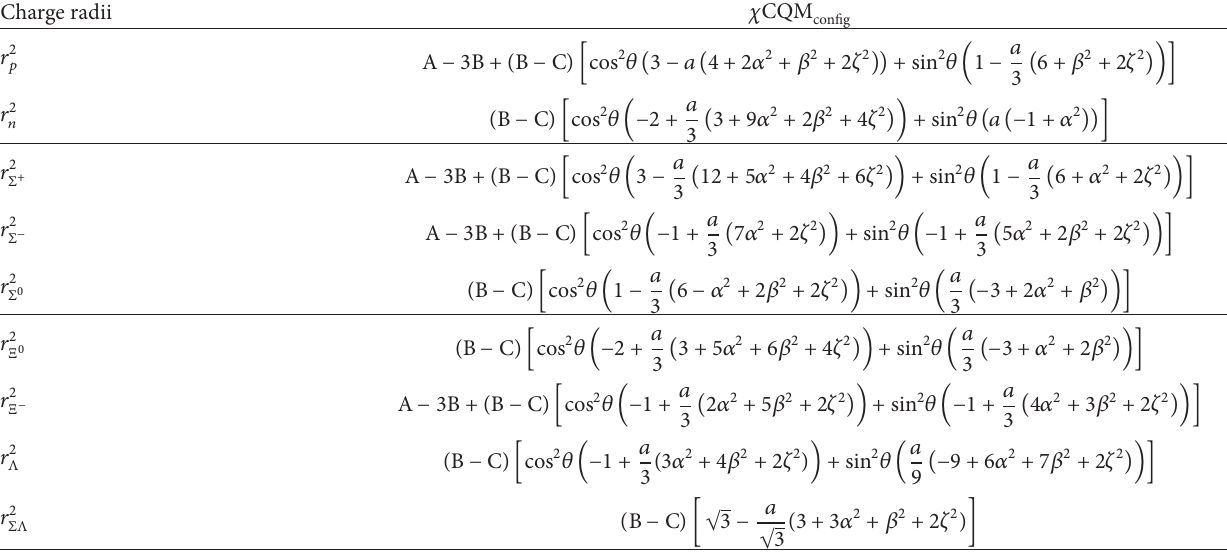
Table 3: Charge radii of octet baryons in 𝜒 CQM in terms of SU (3) symmetry breaking parameters and GPM parameters. These results config are obtained by substituting 𝑞 → 𝑃 𝑞 𝑞 + |𝜓(𝑞)| 2 and 𝑞 ± → 𝑃 𝑞 𝑞 ± + |𝜓(𝑞 ± )| 2 for every constituent quark in NQM. Results in 𝜒 CQM without configuration mixing can easily be obtained by substituting the mixing angle 𝜃 = 0 . Charge radii